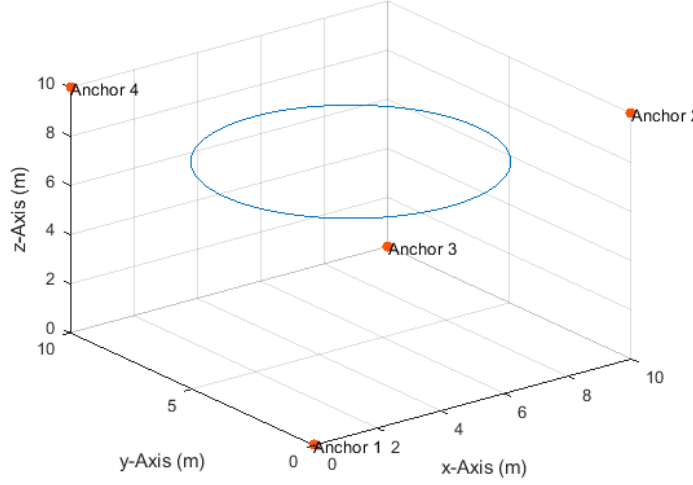
Figure 8. Anchor node arrangement and the horizontal circular path.